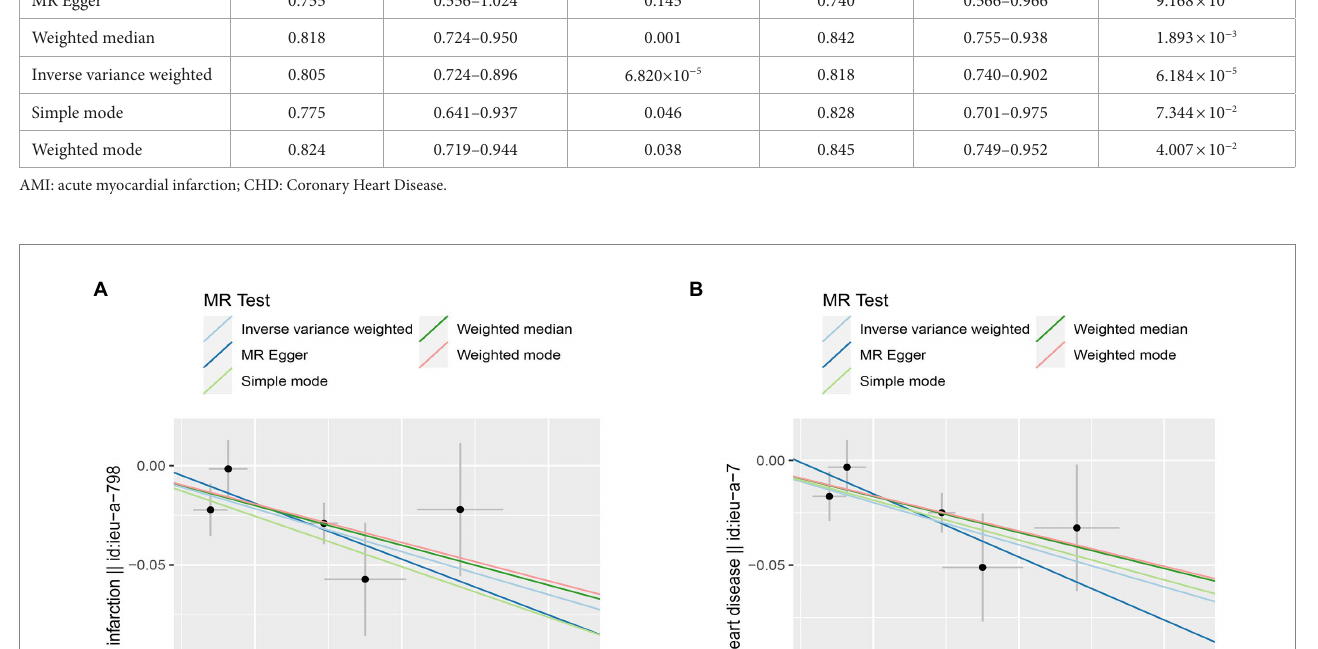
TABLE 3 MR associations of genetic determined OPG ( P < 5 × 10 − 8 ) with AMI or CHD.